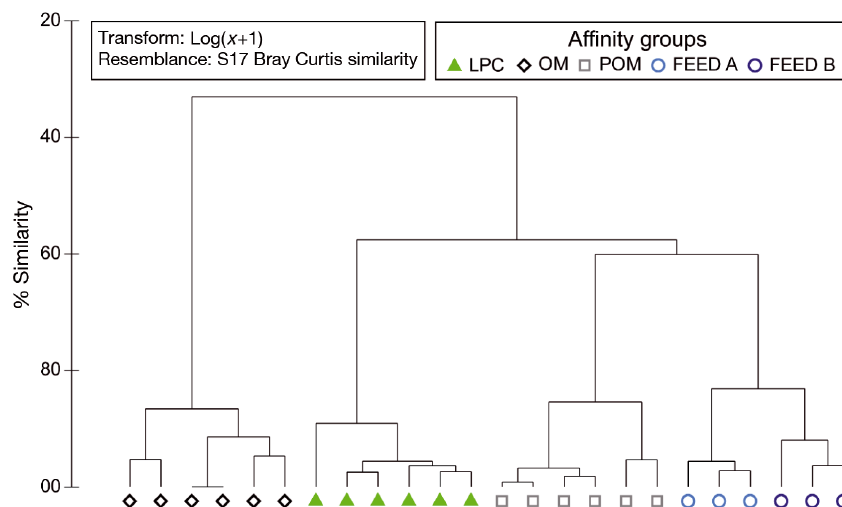
Fig. 2. Hierarchical cluster analysis groups of the fatty acid profiles of large Hediste diversicolor (LPC) cultured in the sand bed tanks, organic matter (OM), particulate organic matter (POM) and fish feed (FEED A and FEED B)